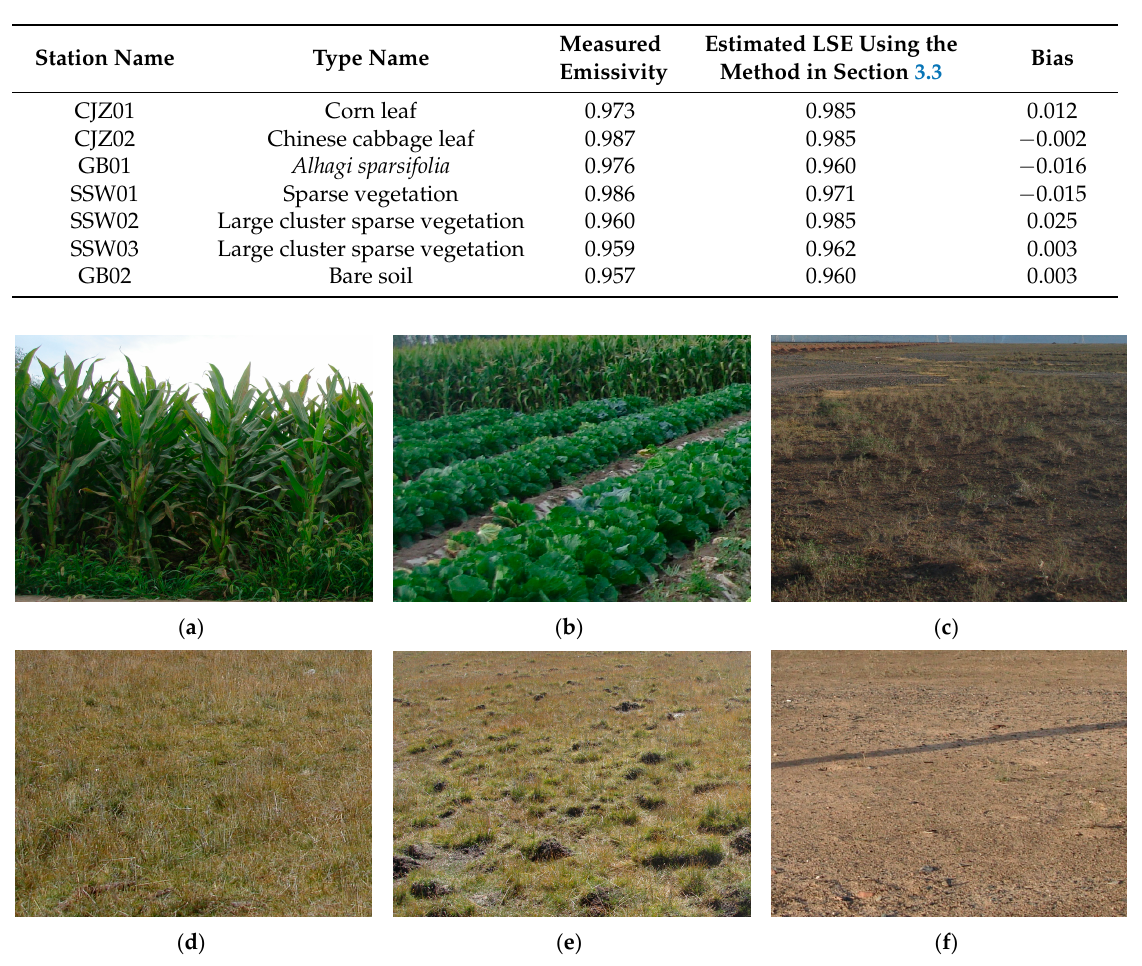
Figure 4. Photos of measurement sites. ( a ) CJZ01; ( b ) CJZ02; ( c ) GB01; ( d ) SSW01; ( e ) SSW02,03; ( f ) GB02.